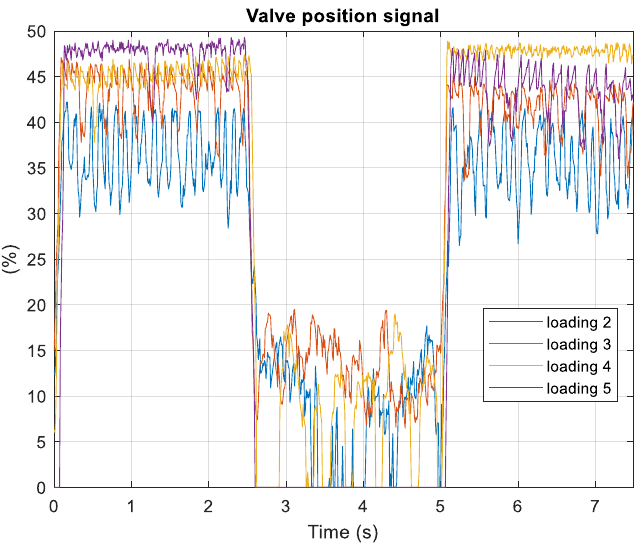
Figure 21. Comparison of LVDT signals for different loading conditions.